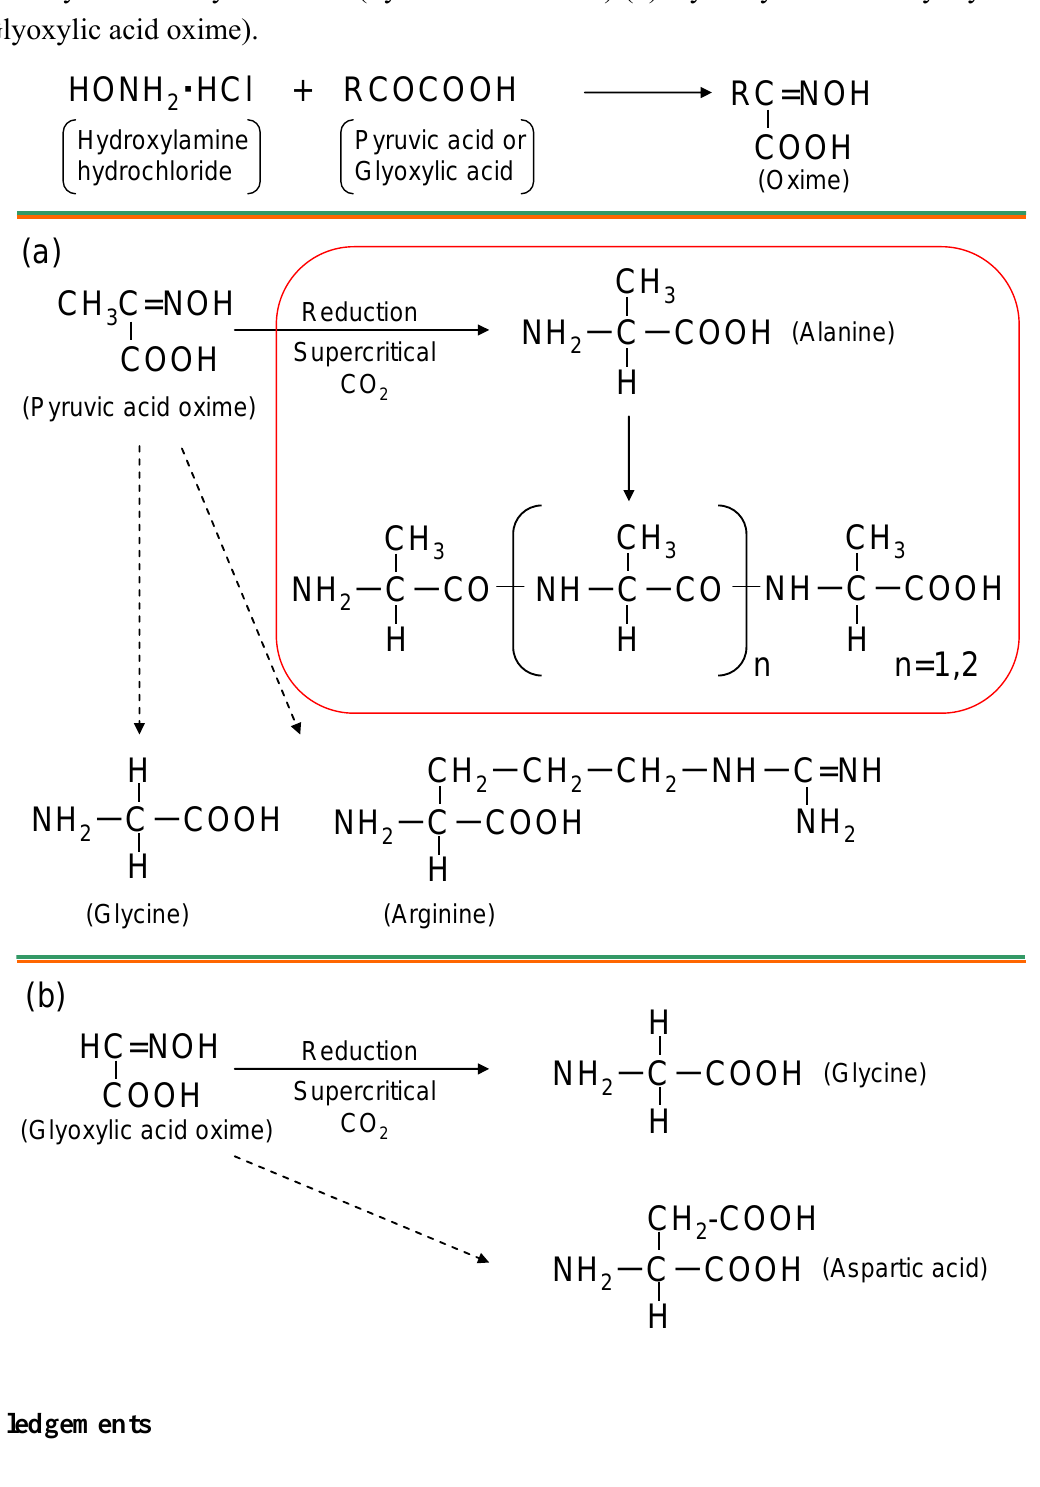
/liquid H O reactions. (a) 2 2